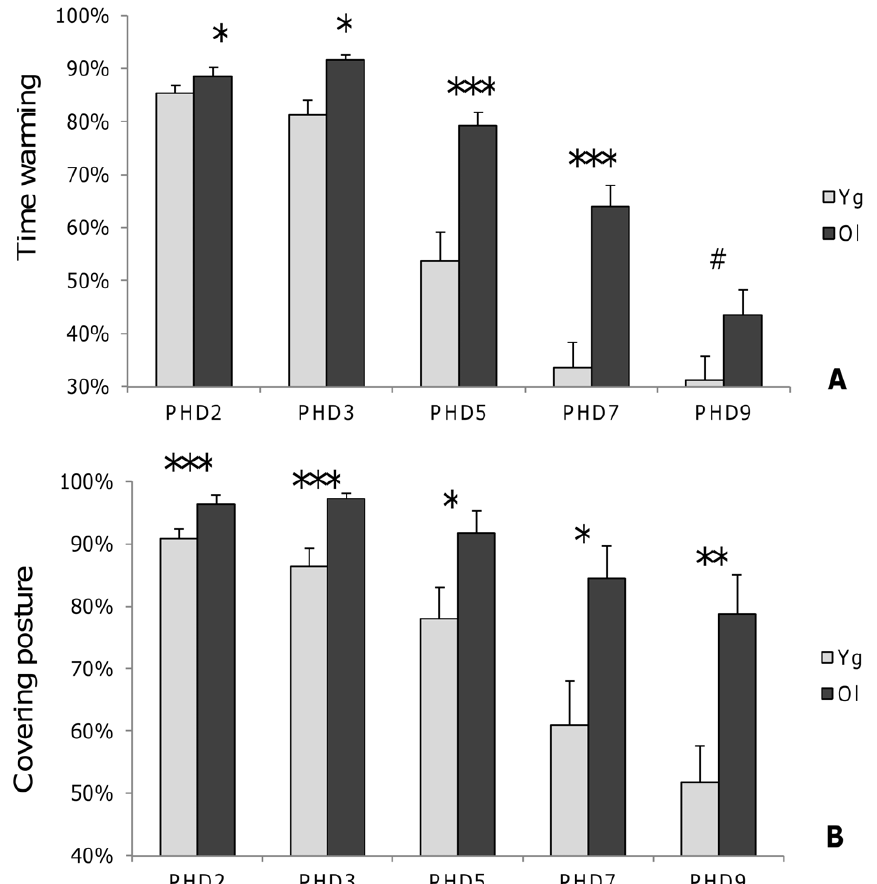
Figure 2. Warming and covering posture rates. Time spent warming (A) and time spent warming in covering posture (B) for the five maternal behaviour observation days (mean 6 SE percentage). Mann-Whitney U-test # 0.1 . p,*: 0.05 . p, **: 0.01 . p, ***: p , 0.001.